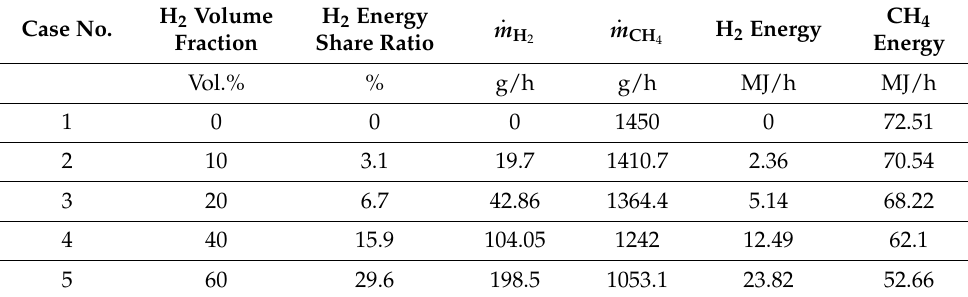
Table 4. Details of gaseous fuel substations and energy share